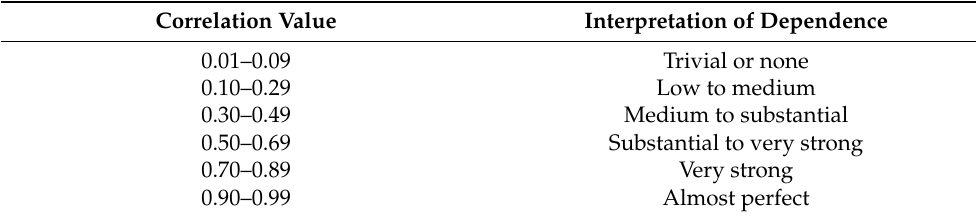
Table 2. Interpretation of Spearman correlation coefficient